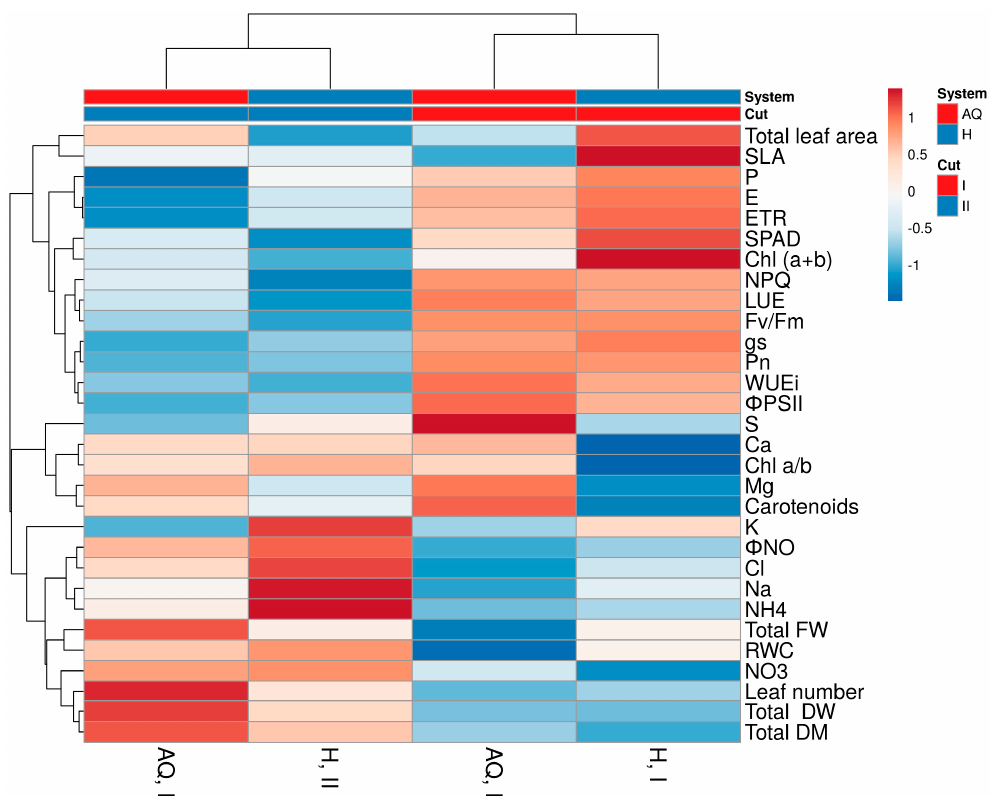
Figure 1. Heatmap cluster analysis in Genovese basil cv Sanremo plants under two consecutive cuts (35 (I) and at 79 (II) days after planting (DAP)) grown under hydroponics (H) or aquaponics (AQ) conditions. Original values are ln (x+1) transformed; data are expressed with Euclidean distances and hierarchical clustering with complete linkage.